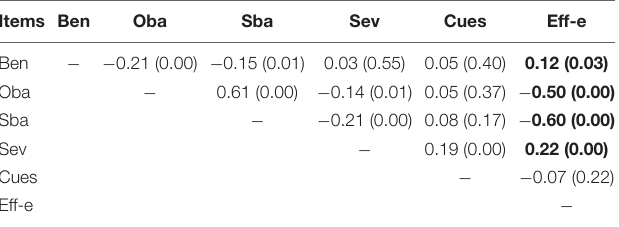
TABLE 4 | The relationship between the variables of exercise health belief ( n =